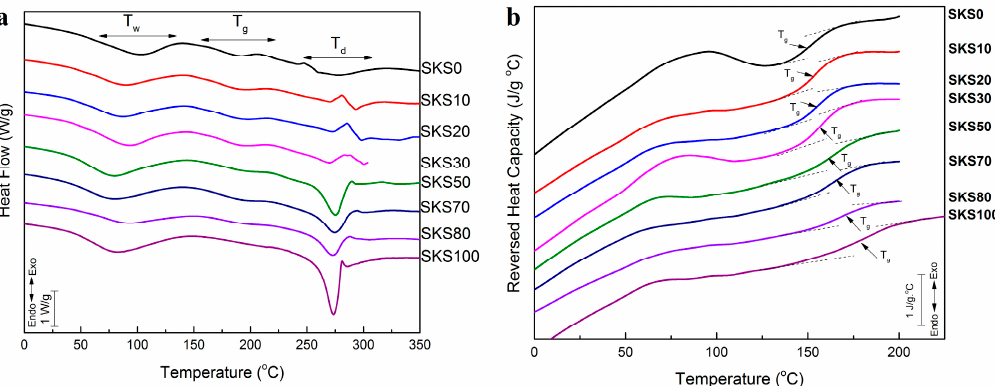
Figure 4. ( a ) Standard DSC scans of ultrasonicated silk/keratin hydrogel/aggregate scaffold samples (SKS10, SKS20, SKS30, SKS50, SKS70, and SKS80) and controls (pure wool (SKS0) and pure silk (SKS100)). The samples were heated at 2 °C·min − 1 from 30 to 350 °C; ( b ) Reversing heat capacities of the samples from 0 to 200 °C (250 °C for pure silk), measured by TM-DSC with a 2 °C·min − 1 heating rate, a modulation period of 60s, and a temperature amplitude of 0.318 °C. Table 3. Thermal properties of ultrasonication-induced silk fibroin/keratin hydrogel blend